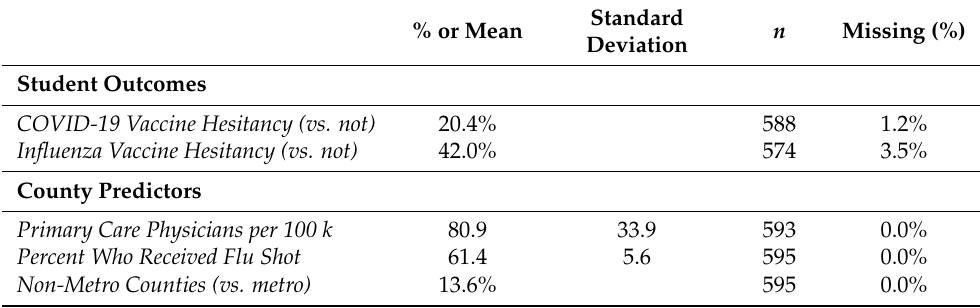
Table 2. Individual-Level Descriptive